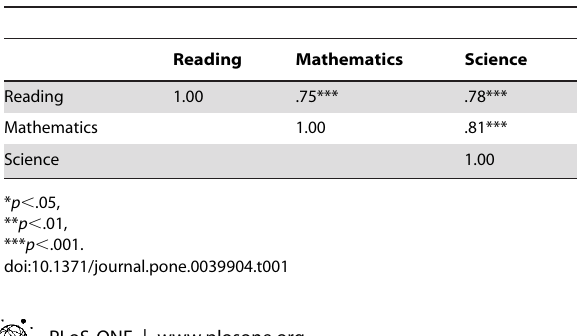
Table 1. Correlations between National Gender Differences for PISA Reading, Mathematics, and Science Performance (All